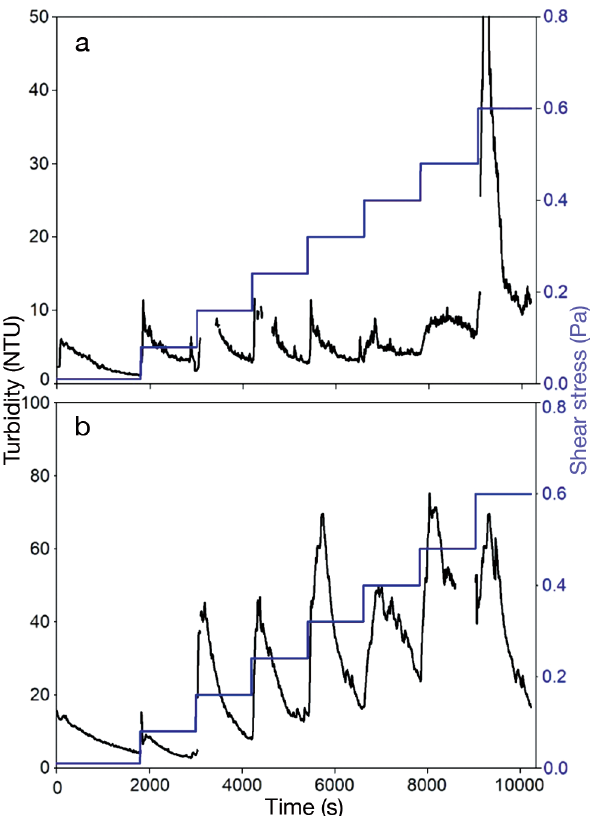
Fig. 4. Turbidity and applied shear stress versus time from the Gust chamber erosion experiments. (a) Typical erosion exper- iment from Jordan Bay with the bulk of mass being eroded in the last 2 shear stress steps. (b) Typical erosion experiment from Navy Island where mass eroded is similar over the shear stress steps. NTU: nephelometer turbidity units